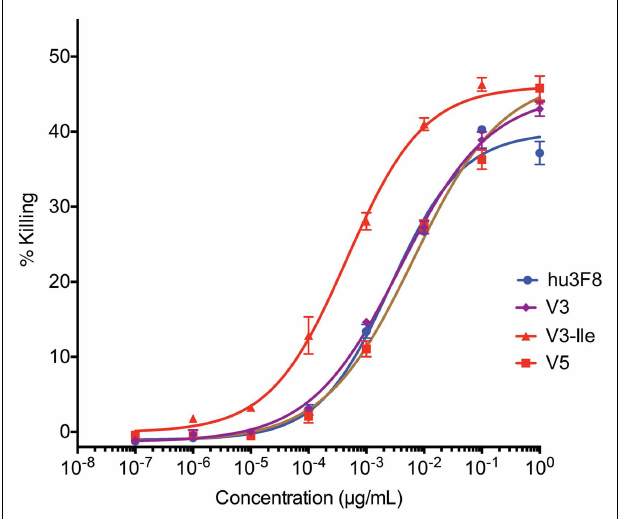
FIGURE 3 | In vitro antibody-dependent cell-mediated cytotoxicity assay of human neuroblastoma LAN-1 target cells . Antibodies were applied to LAN-1 cells in the presence of NK-92MI cells stably transfected with the human CD16 Fc receptor, at an effector:target ratio of 20:1. Samples were prepared in triplicate, and cytotoxicity was measured by 51 chromium release.Values are shown as mean ± standard error.